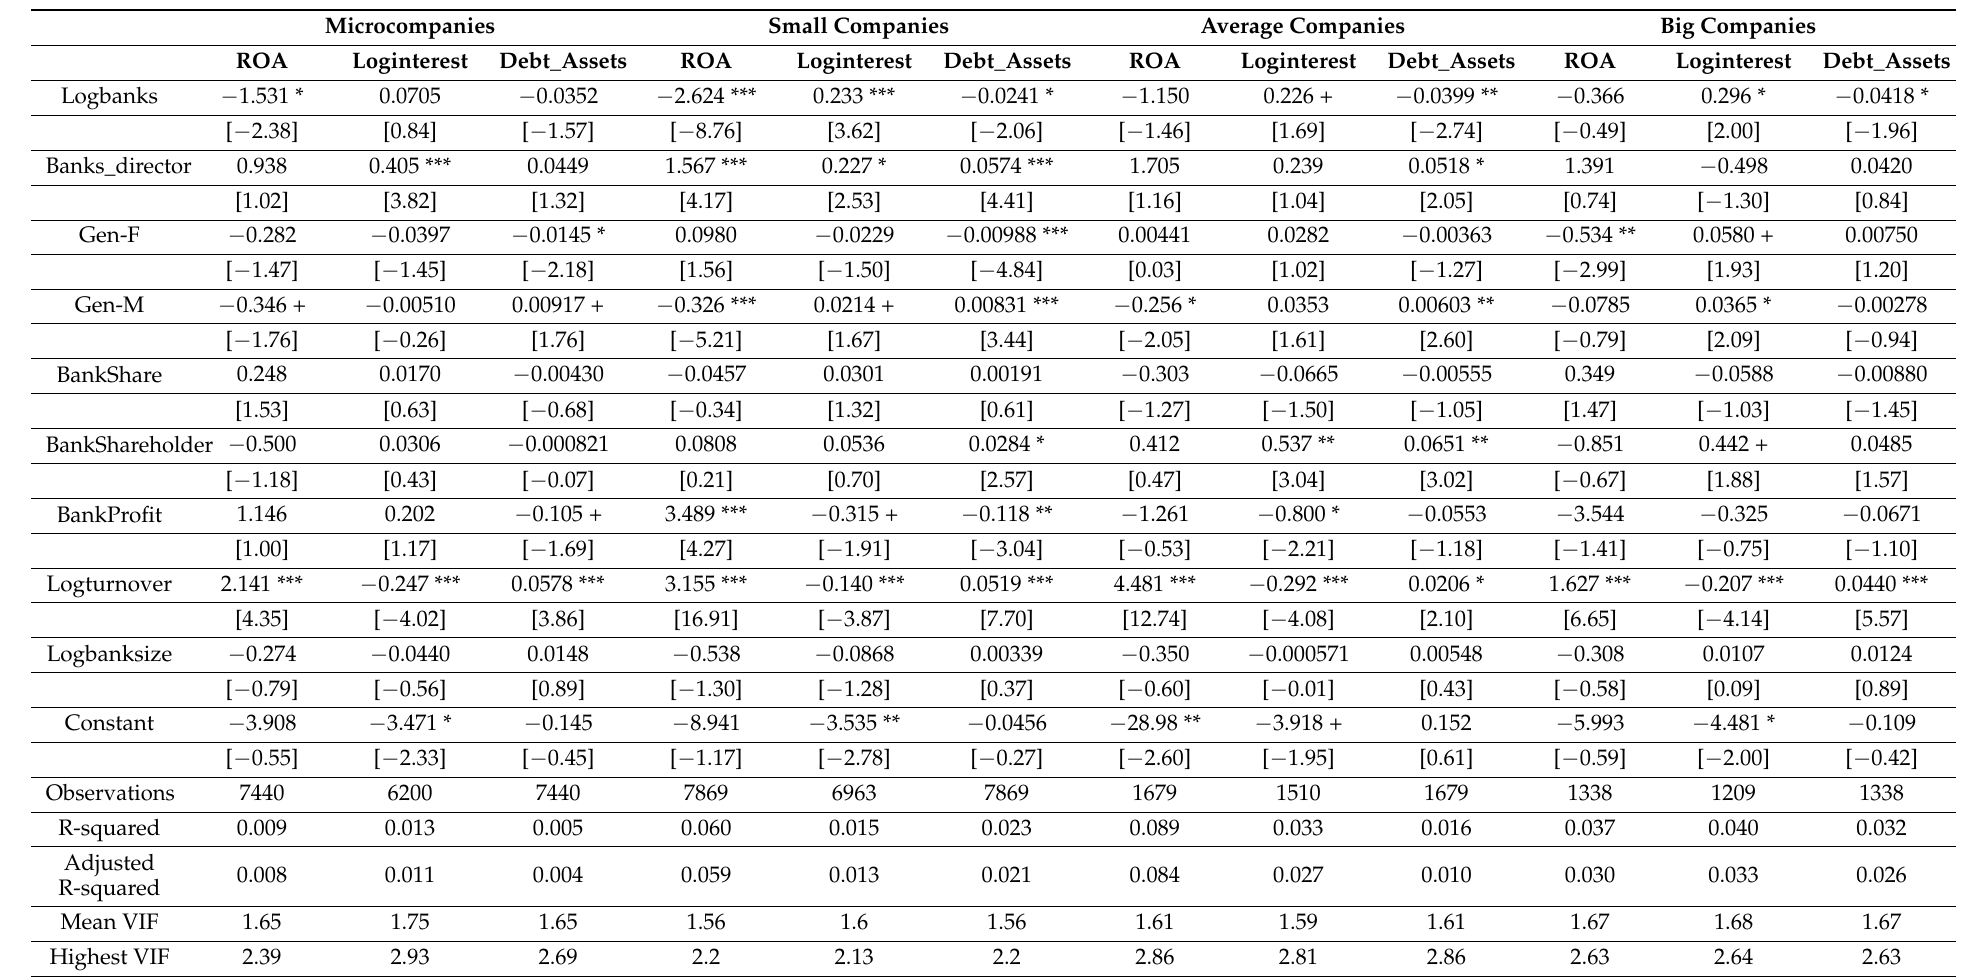
Table 6. Estimation by company